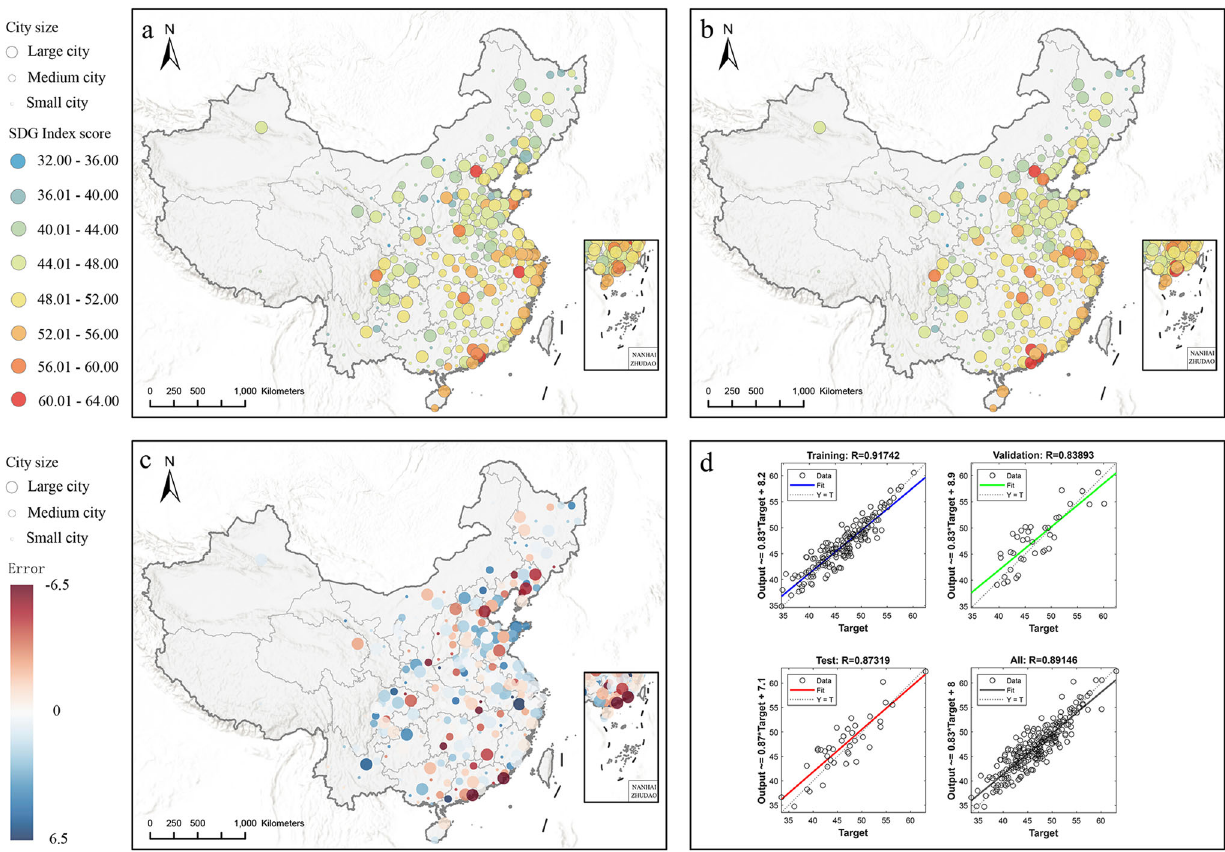
Fig. 3 Proposed ANN model performance. a SDG Index scores for 254 cities (statistical data). b SDG Index scores for 254 cities (ANN model using big data). c Difference between the two SDG Index scores for 254 cities. d Correlation results (training, validation, test, and entire sets) for the ANN model. The base map in Fig. 3a – c was downloaded from the Resource and Environment Science and Data Center (https://www.resdc.cn/Datalist1.aspx? FieldTyepID = 20,0). The background map in Fig. 3a – c is the online basemap (World Hillshade) of ArcGIS Pro software from Esri